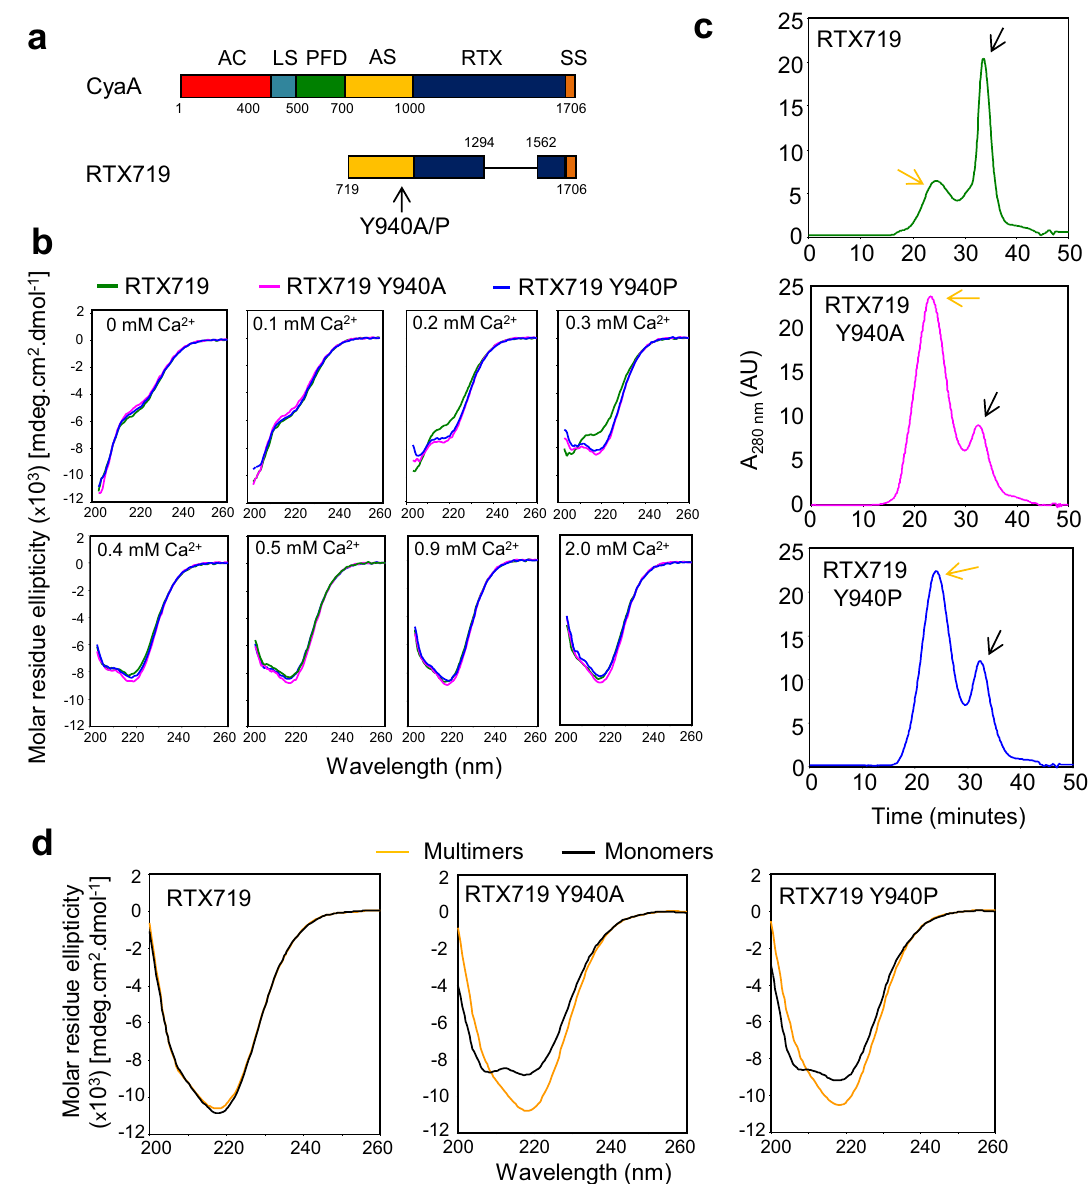
Figure 2. The Y940 residue plays a key structural role in the folding of the acylated segment of CyaA ( a ) Schematic representation of the CyaA and CyaA-derived RTX719. AC, adenylate cyclase domain; LS, AC-to-Hly linker segment; PFD, pore-forming domain; AS, acylated segment; RTX, calcium-binding repeats; SS, secretion signal. ( b ) Far-UV CD spectra of the RTX719, RTX719 Y940A and RTX719 Y940P proteins (200 μg/ml) in the absence and the presence of CaCl 2 . The data correspond to the average of two independent experiments with 3 accumulations per spectrum. ( c ) Gel filtration chromatography was performed on a Superdex 200HR gel filtration column. The column was equilibrated with a buffer containing 20 mM Tris–HCl (pH 8.0), 150 mM NaCl and 2 mM CaCl 2 before the denatured proteins (400 µg in 50 mM Tris–HCl pH 8.0, 8 M urea and 300 mM NaCl) were loaded onto the column and refolded at a flow rate of 0.5 ml/min. The orange and black arrow indicates multimeric and monomeric state of CyaA constructs, respectively. ( d ) Far-UV CD spectra of the multimeric and monomeric forms of the RTX719, RTX719 Y940A and RTX719 Y940P proteins (100 µg/ml) in 20 mM Tris–HCl (pH 8.0), 150 mM NaCl and 2 mM CaCl 2